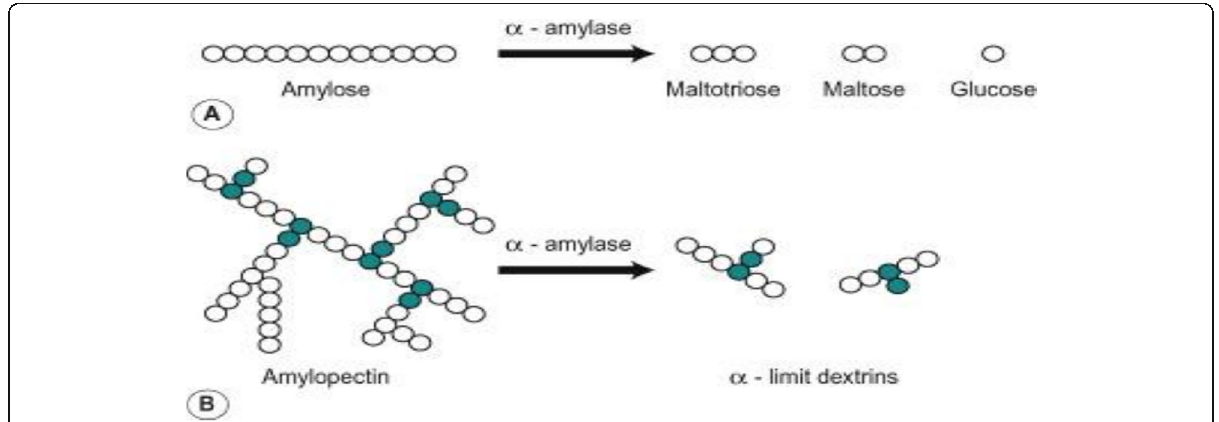
Fig. 1 Schematic representation of starch (amylose and amylopectin) and mode of action of α